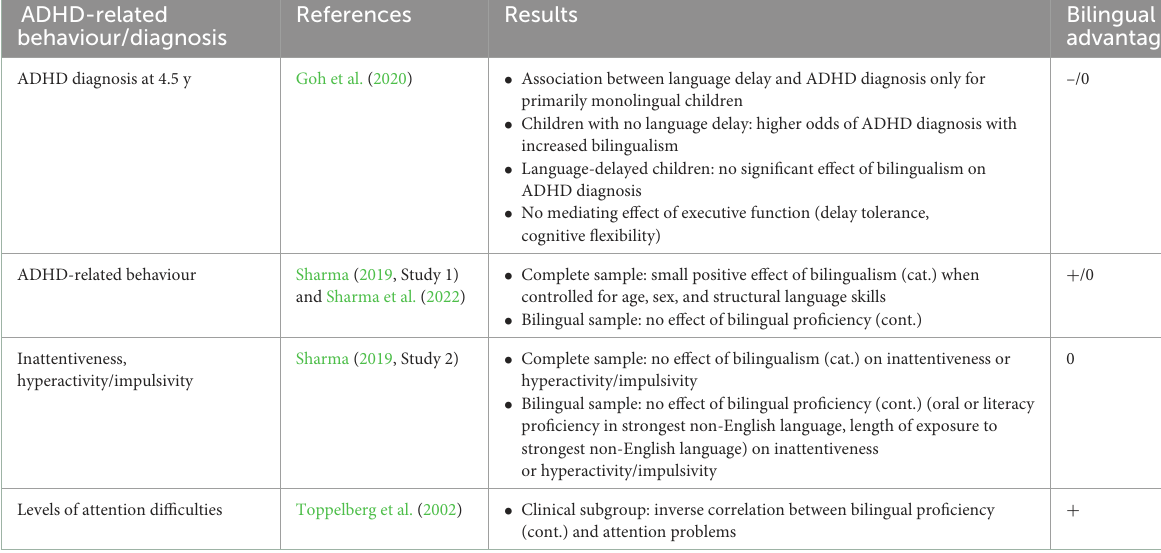
TABLE 3 Effect of bilingualism on ADHD-related behaviour/ADHD diagnosis. ADHD-related